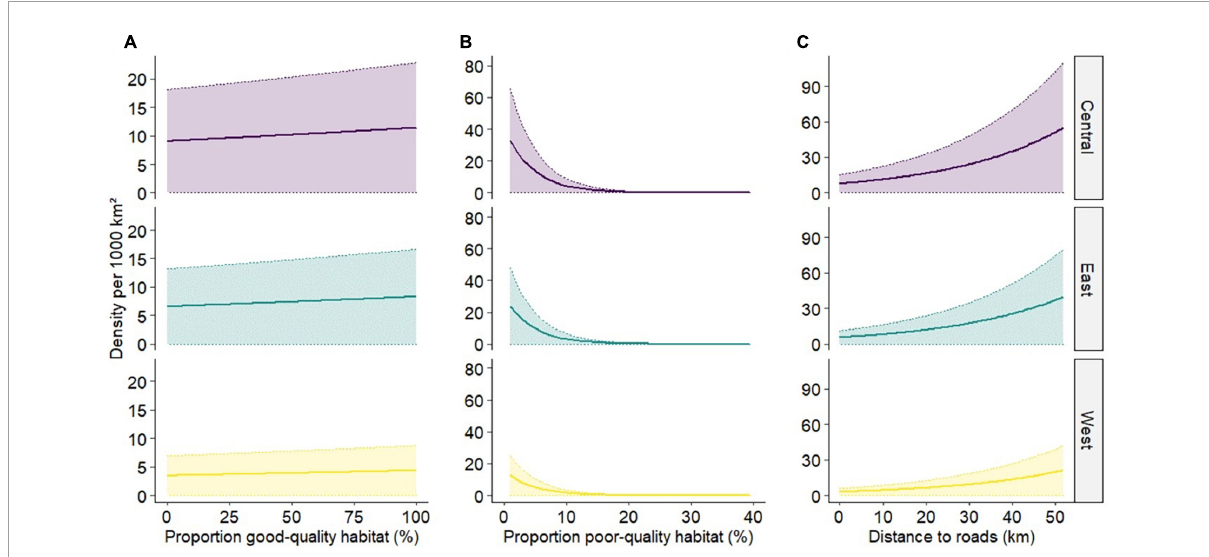
FIGURE2 Predicted responses of the top density model showing the relationships between (A) good-quality habitat and caribou density, (B) poor-quality habitat and caribou density, and (C) distance to linear features and caribou density.